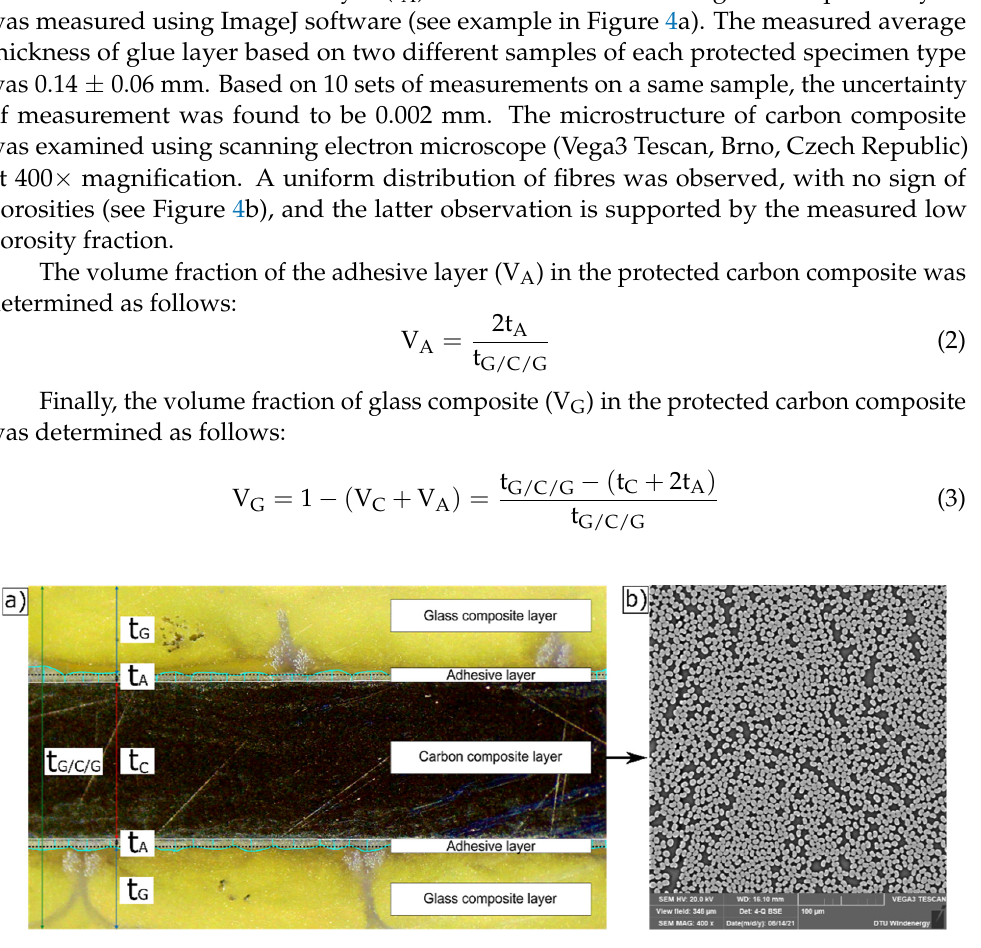
Figure 4. ( a ) Optical microscopy image of protected carbon composite specimen showing the three composite layers and the two adhesive layers between them, ( b ) representative SEM image showing microstructure of carbon composite layer.